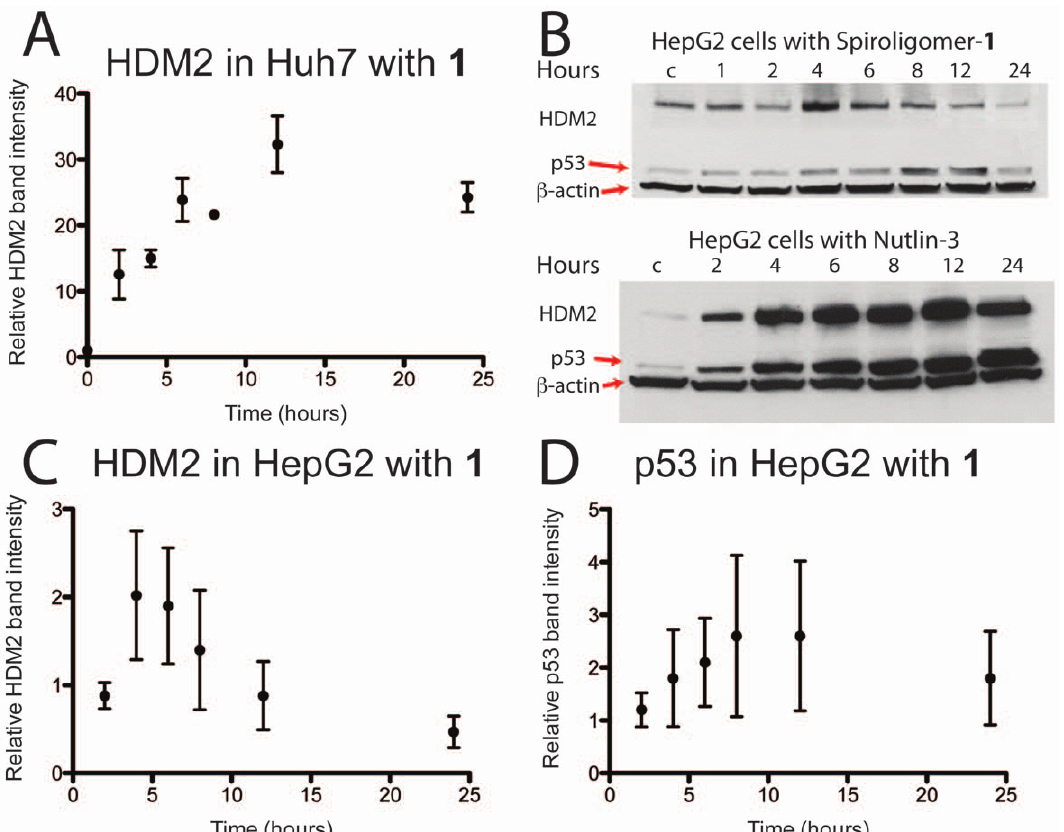
Figure 11. Time dependent Western analysis of spiroligomer 1 (15 m M) and Nutlin-3 (15 m M) added to Huh7 and HepG2 cells. (A) Relative HDM2 band intensity obtained when compound 1 was incubated with Huh7 cells. This plot is the average of two gels and shows a greater than 30-fold increase in the levels of HDM2. (B) Representative western gels showing the effect on HDM2 and wt-p53 in HepG2 cells in the presence of compound 1 and Nutlin-3. (C) Plotted average HDM2 band intensity relative to control (intensity of 1) as a function of time of HepG2 cells incubated with compound 1 at 15 m M. (D) Plotted average of p53 band intensity relative to control (intensity of 1) as a function of time of HepG2 cells incubated with compound 1 at 15 m M. In (C) and (D) the results of six gels (see supporting information) are averaged and standard deviations are plotted on the data. Compound 1 leads to a transient increase in HDM2 levels at 4 hours followed by a decrease. The level of p53 also increases transiently and then decreases again and the p53 changes trail the HDM2